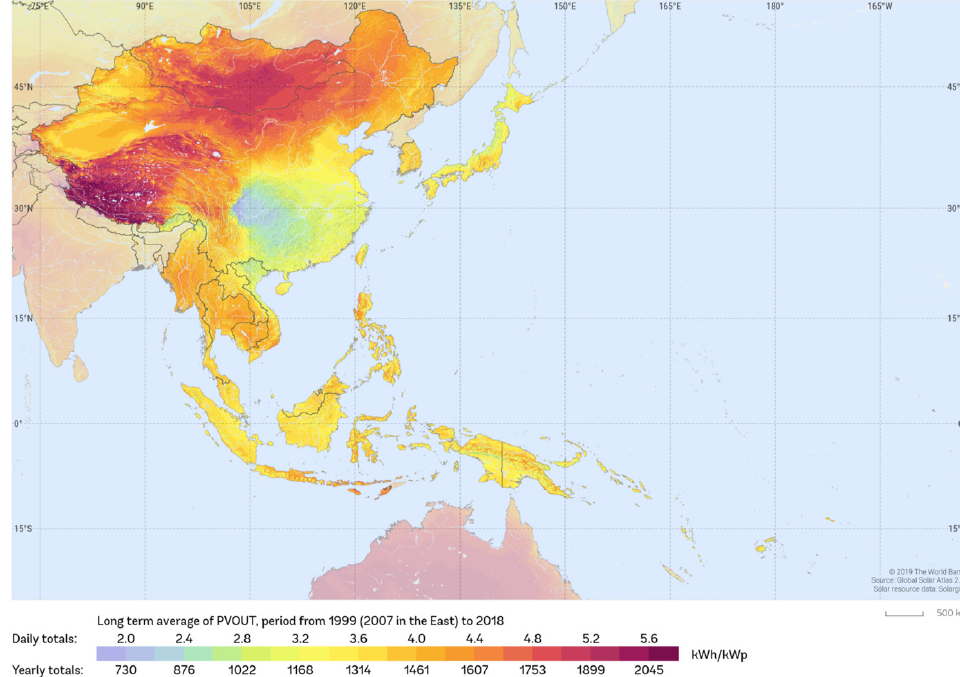
Figure 5. Solar resource map of Asia [23].